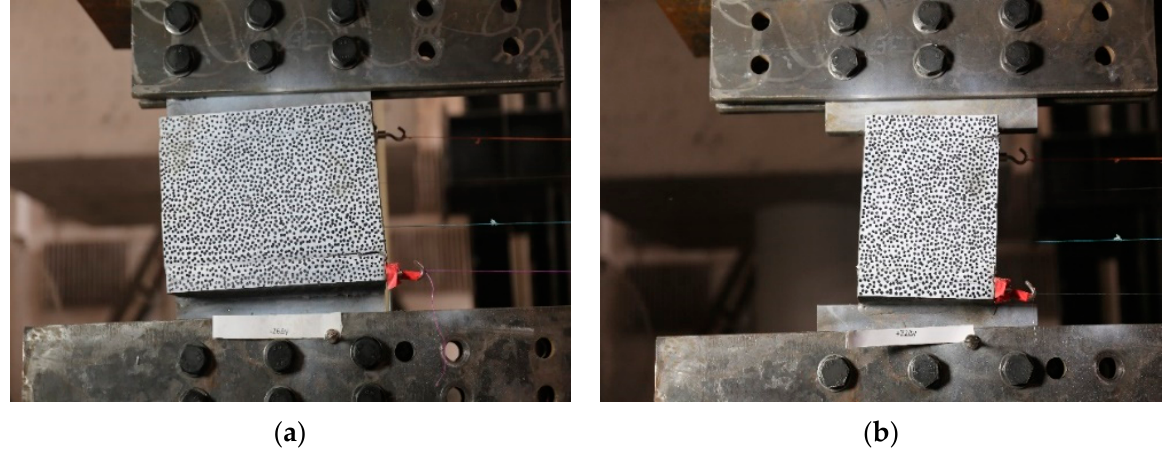
Figure 7. Failure modes of the welded steel tube dampers: ( a ) steel tube end of 150-C3 tearing; ( b ) weld of 200-A1 cracking.